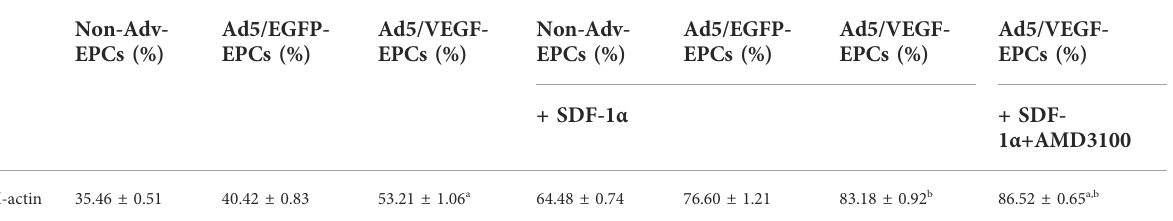
TABLE 2 Positive staining of VSMC surface